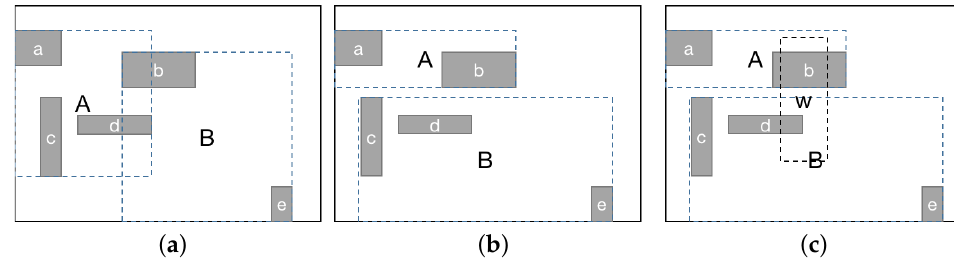
Figure 1. R-tree and R*-tree. ( a ) R-tree. ( b ) R*-tree. ( c ) R*-tree with query